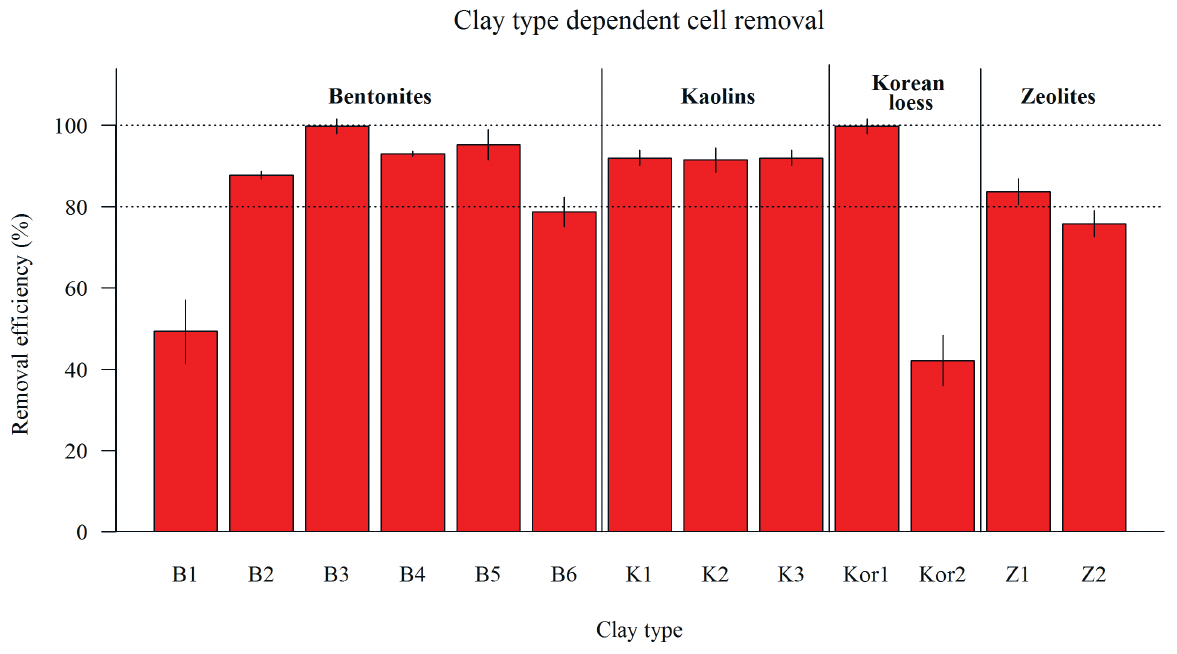
Figure 4. Removal efficiency of P. parvum cells by different clay types.